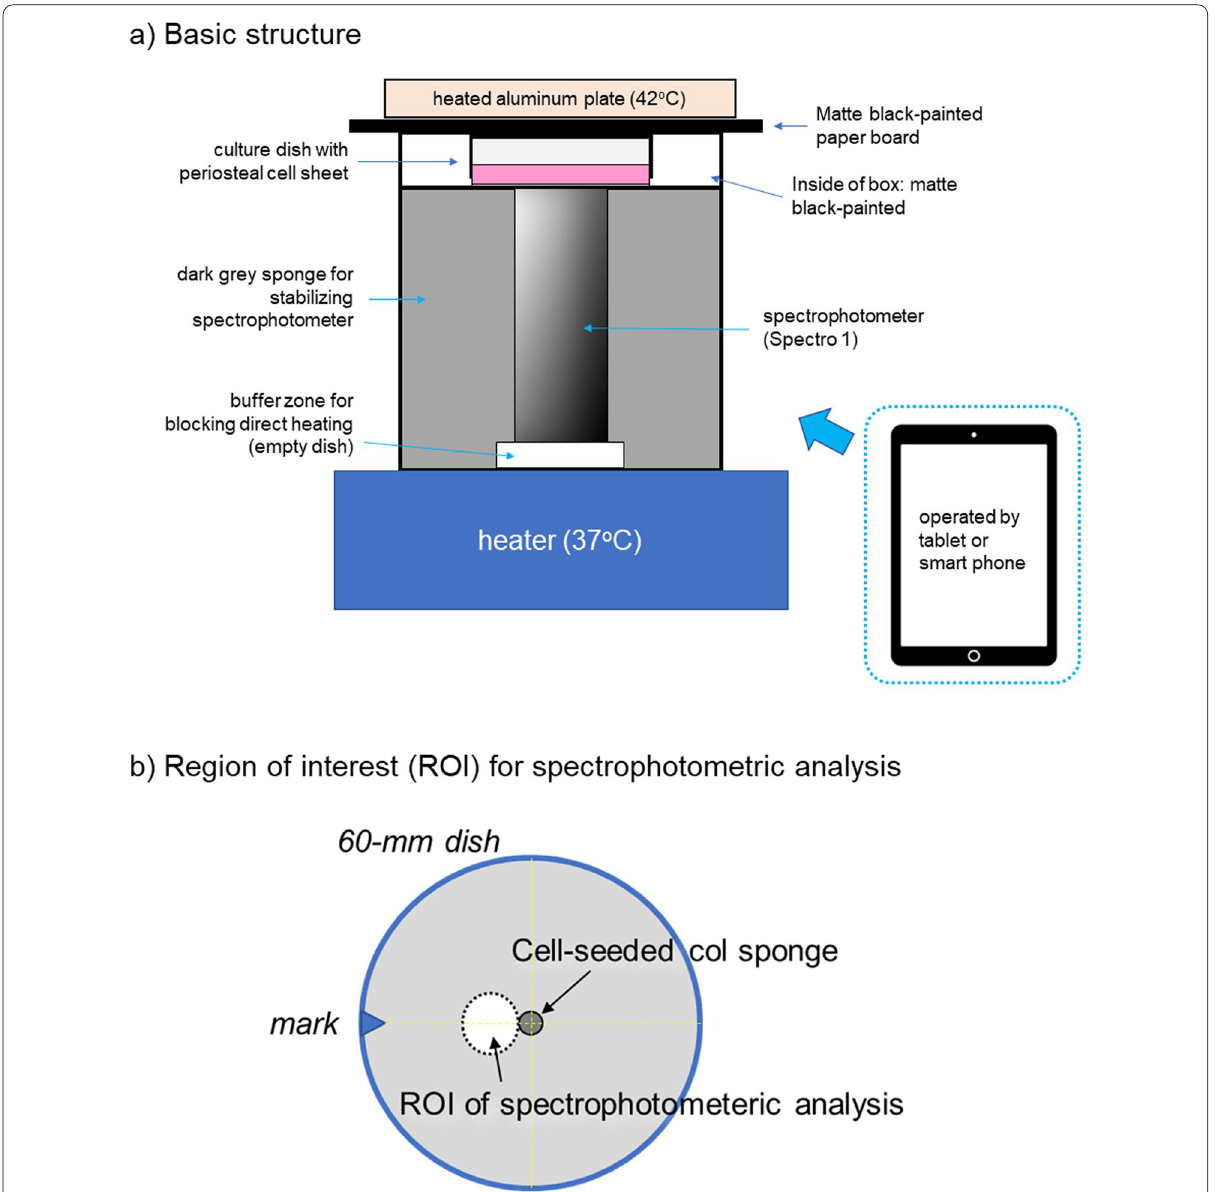
Fig. 2 Schema for a spectrophotometric device assembly and b region of interest for the spectrophotometric